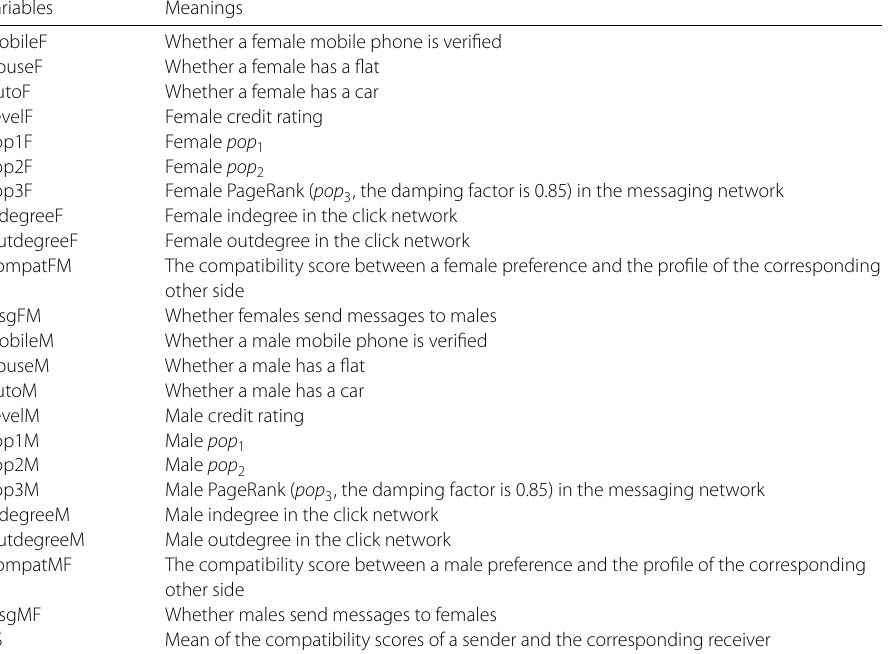
Table 1 Variables and their corresponding meanings Variables Meanings MobileF